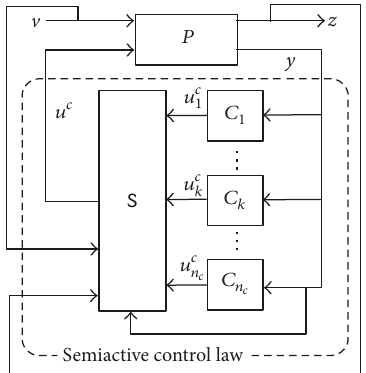
Figure 2: Block diagram of the adaptive gain scheduling semiactive controlsystemwith 𝐶 𝑘 , 𝑘 = 1,...,𝑛 𝑐 ,andtheschedulingmechanism S .